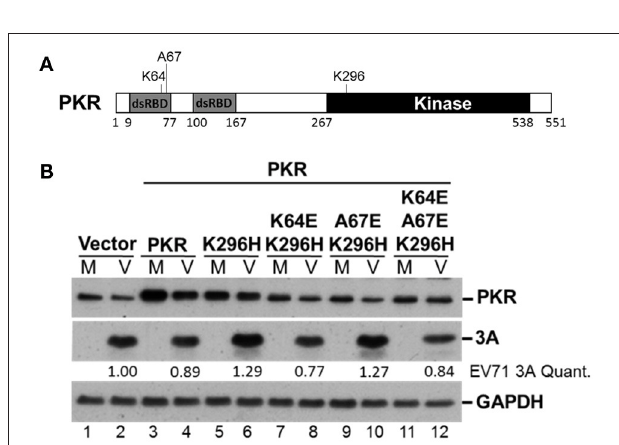
FIGURE 6 | The PKR mutant K296H increases the viral protein accumulation caused by the dsRNA binding domain. (A) Schematic representation of the PKR mutants. (B) Plasmids encoding vector alone, PKR, K296H, K64E/K296H, A67E/K296H, or K64E/A67E/K296H were transfected into RD cells, which were then selected by the addition of 3 µ g/mL puromycin. Stable expressing cells were infected with EV-A71 at an m.o.i of 10 and the cellular extracts were harvested after 8 h. Immunoblot analysis was performed to detect PKR, viral 3A protein, and GAPDH. The relative amount of 3A protein was quantified by densitometry and was first normalized to GAPDH and then to that of the vector control. A representative result based on three independent experiments is